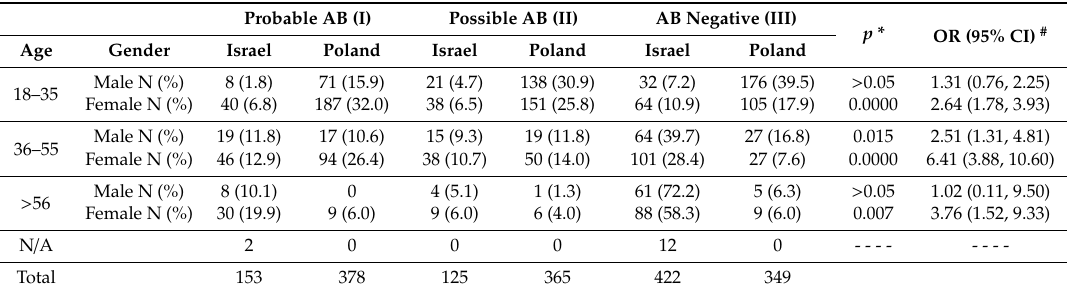
Table 4. Awake bruxism (AB)